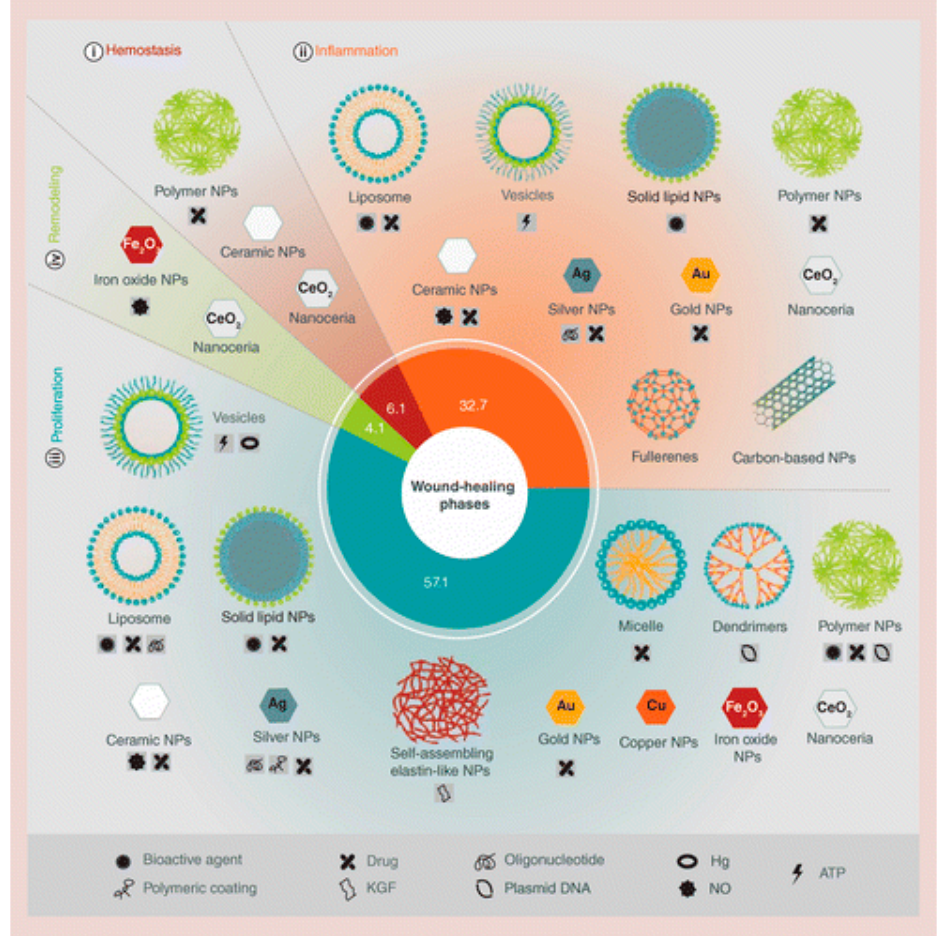
Figure 5. Different nanomaterials and their beneficial effects on the phase/s of wound healing. Republished with permission of Future Medicine Ltd. from [45].